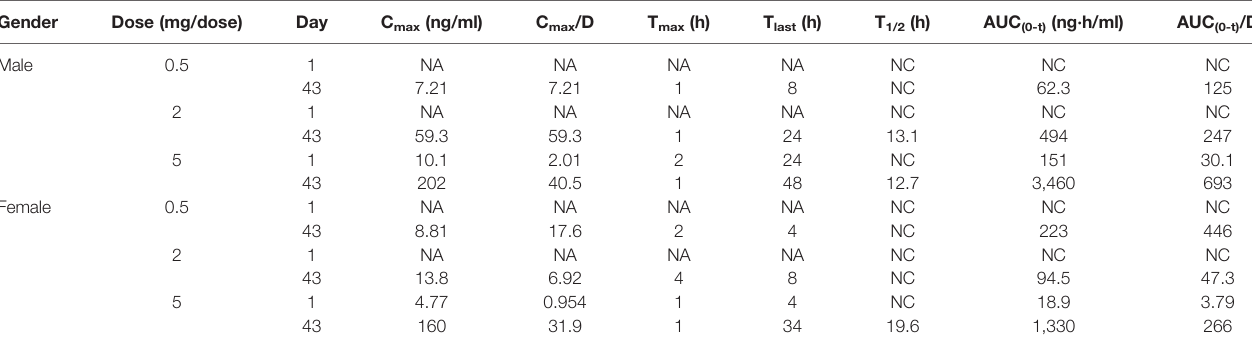
TABLE 3 | Mean toxicokinetic parameters for Api2568 in male and female monkeys on day 1 and day 43. Gender Dose (mg/dose)